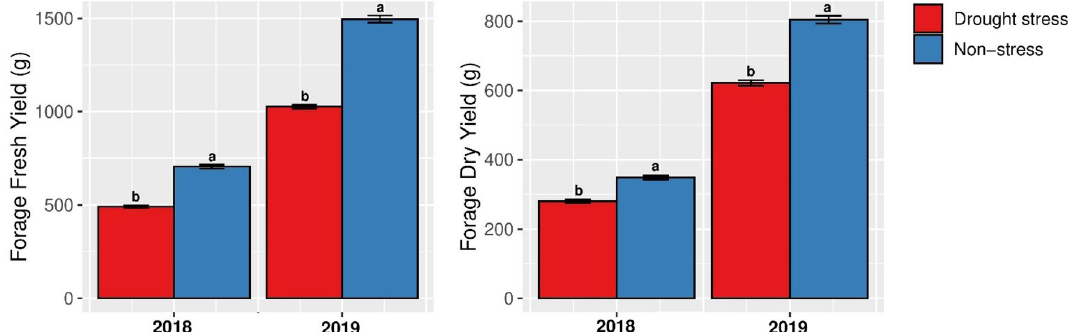
Figure 2. Mean for fresh and dry forage yields of 100 Poa pratensis accessions evaluated in non-stress and drought stress conditions in 2018 and 2019. Different letters ( a, b ) represent significant differences between non- stress and drought stress condition in each year at P <